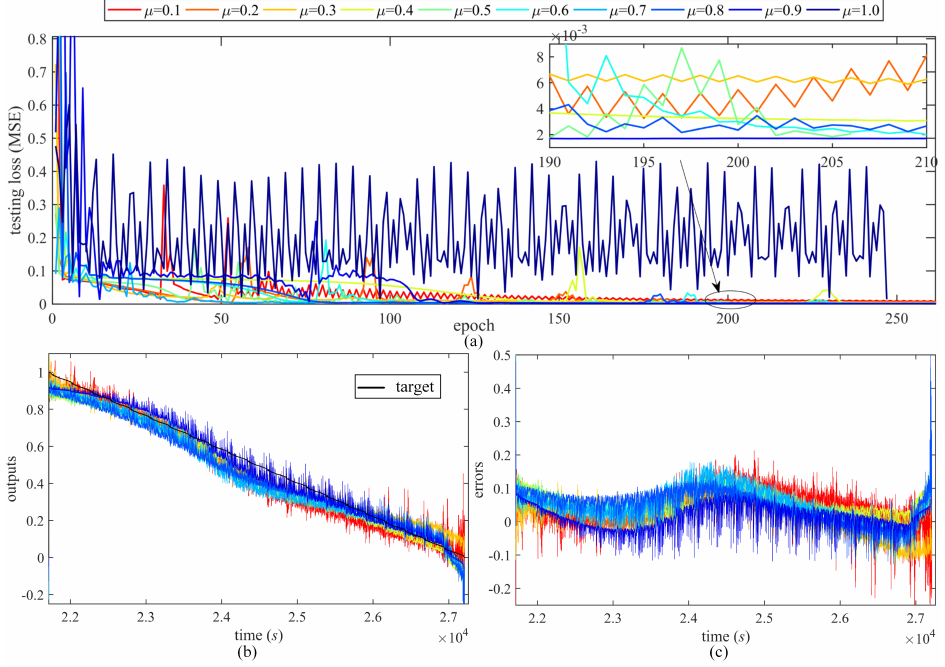
Figure 9. Sensitivity of the momentum of fractional-order gradient, µ = 0.1:0.1:1, ( a ) testing loss, ( b ) testing outputs, and ( c ) testing errors.